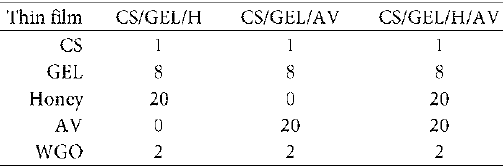
Fig. 3. Photographic appearance of (A) CS/GEL/H (2% W/V), CS/GEL/H (5% W/V), CS/GEL/H (10% W/V) , (B) CS/GEL/H(20% 1 2 3 W/V), CS/GEL/AV, CS/GEL/H/AV thin films Figure 3 . Photographic appearance of (A) CS/GEL/H 1 (2% W/V), CS/GEL/H 2 (5% W/V), CS/GEL/H 3 (10% W/V) , (B) CS/GEL/H (20% W/V) , CS/GEL/AV, CS/GEL/H/AV thin films Table 2. Preparation data of thin films. Unit: